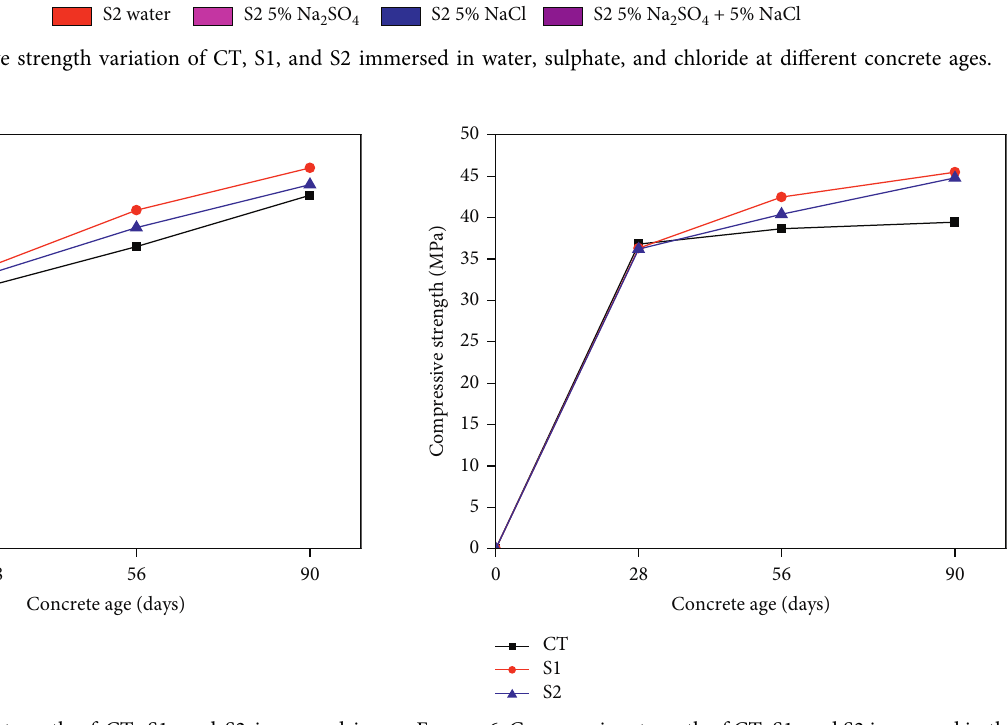
Figure 6: Compressive strength of CT, S1, and S2 immersed in the sulphate